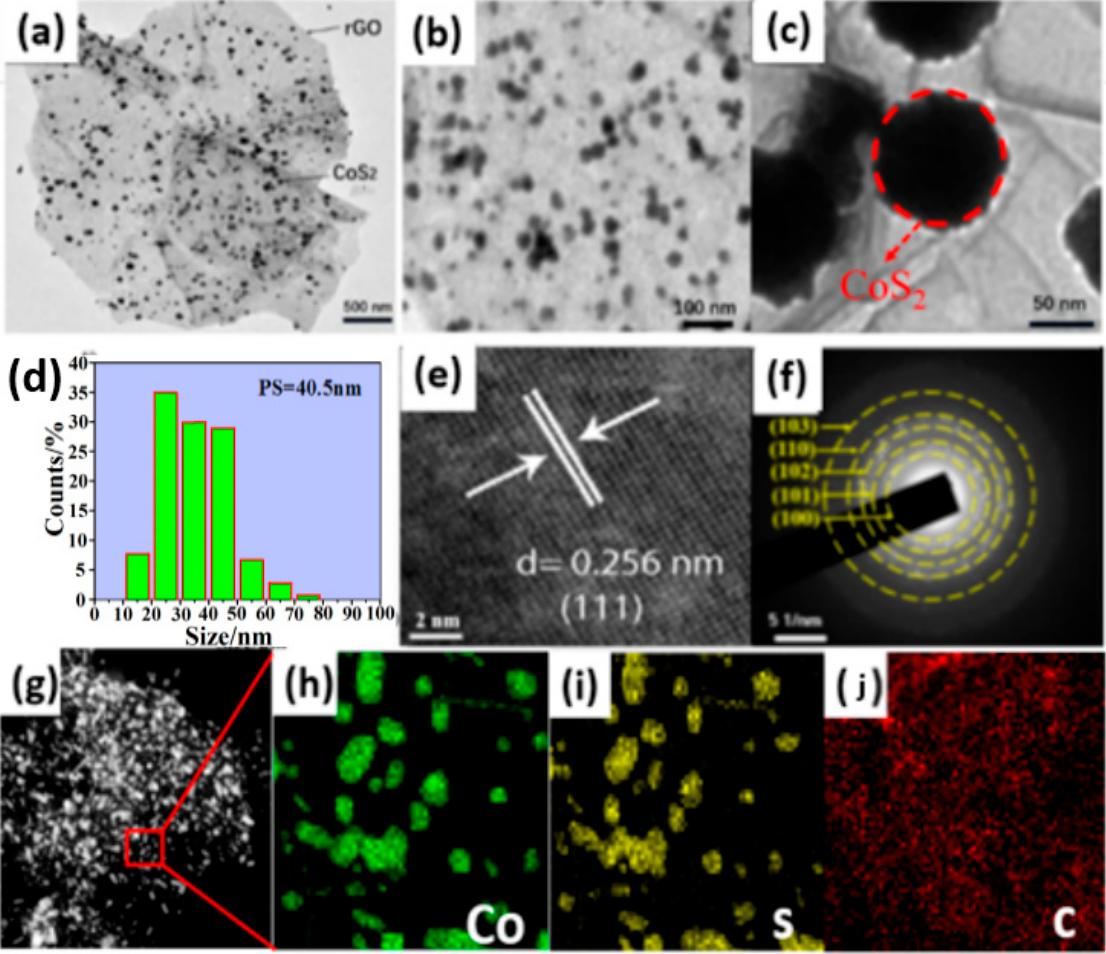
Figure 2. ( a – c ) TEM images of CoS 2 @rGO. ( d ) The particle size distribution of CoS 2 @rGO composites. ( e , f ) HRTEM image and selected area electron diffraction pattern of CoS 2 @rGO. ( g – j ) Elemental mapping images of CoS 2 @rGO